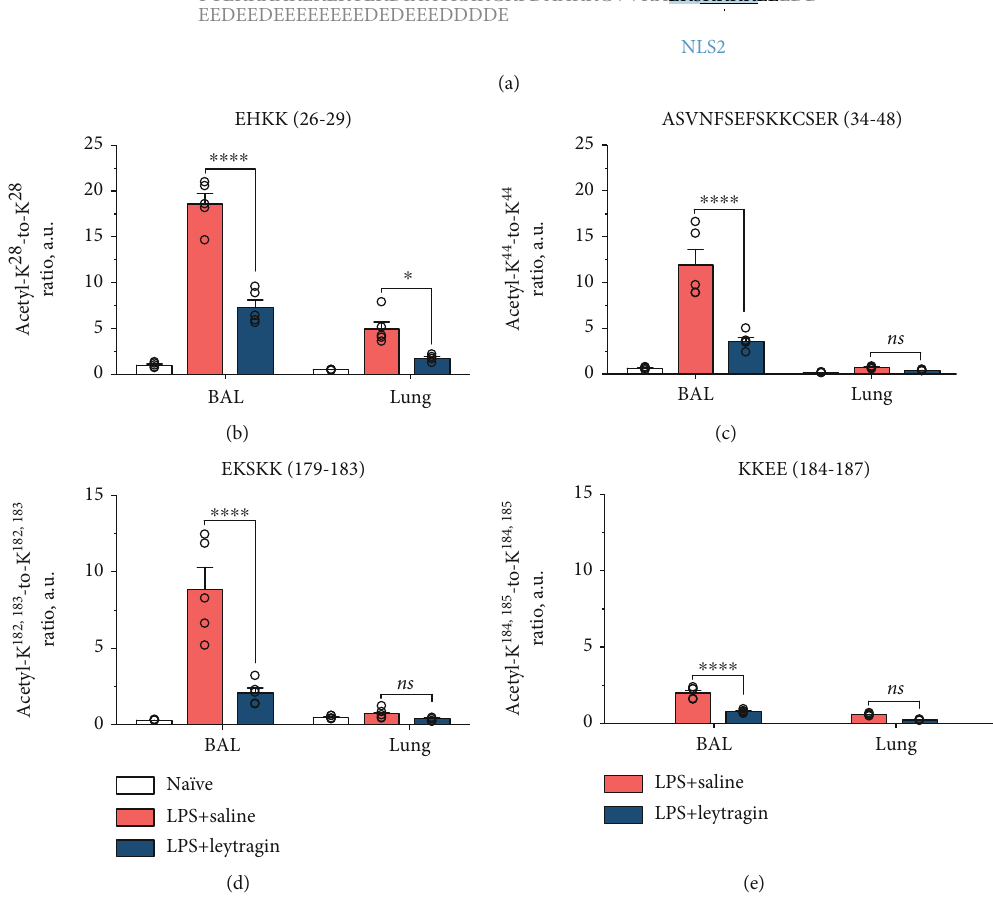
Figure 3: E ff ects of leytragin on the acetylation state of HMGB1 in samples of BALs and lungs from LPS-induced mice. (a) HMGB1 sequence with indicated tryptic peptides corresponding to HMGB1 fragments and overlapping with NLS sequences within HMGB1. Acetylated-to-nonacetylated ratios (acetyl-K/K) for (b) K 28 within EHKK, (c) K 44 within ASVNFSEFSKKCSER, (d) K 182,183 within EKSKK, and (e) K 184,185 within KKEE in BALs and lungs obtained from naïve mice and LPS-induced mice treated with leytragin or saline. Ns: nonsigni fi cant, ∗ p < 0 : 05 , and ∗∗∗∗ p < 0 : 0001 vs. LPS+saline. One-way ANOVA followed by Tukey ’ s post hoc test (see the text); 5 animals per group were used. Bars represent the mean ± SEM